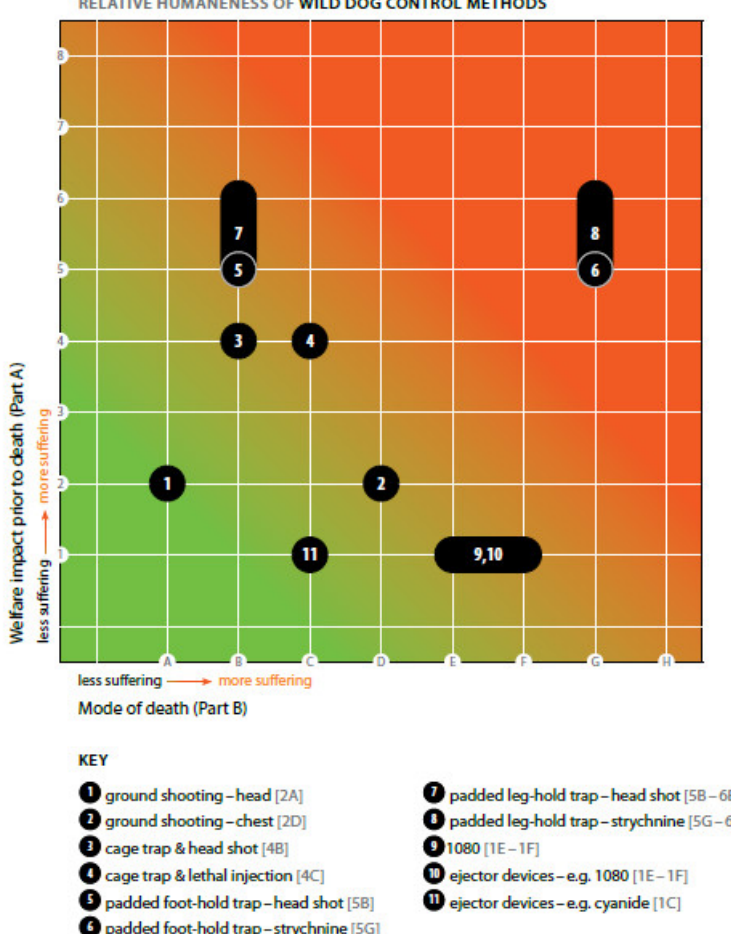
Figure 3. Summary of the relative welfare impacts of various methods of lethally controlling wild dogs ( Canis familiaris ) in Australia, including various restraining traps, using the Sharp and Saunders humaneness assessment model. Reprinted from A model for assessing the relative humaneness of pest animal control methods. Second edition. (p. 124), by T. Sharp and G. Saunders, 2011, Australian Government Department of Agriculture, Fisheries and Forestry. Reprinted with authors’